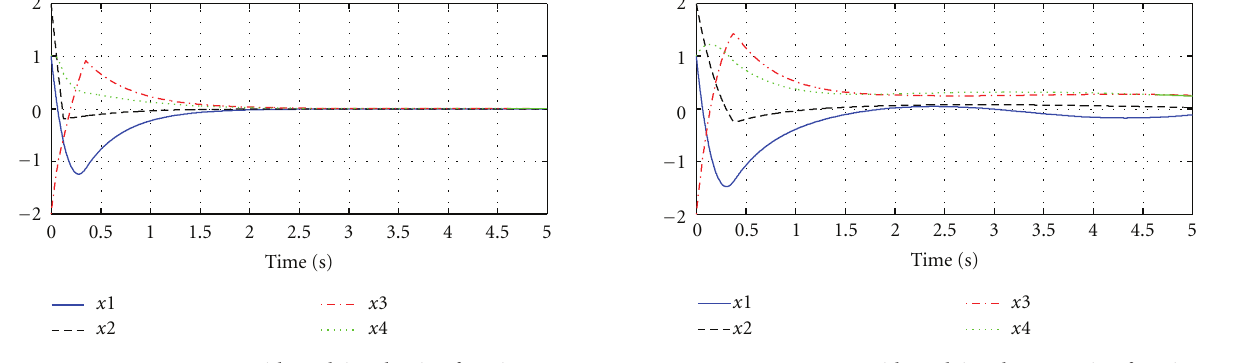
Figure 2: System states with applying the sign function.